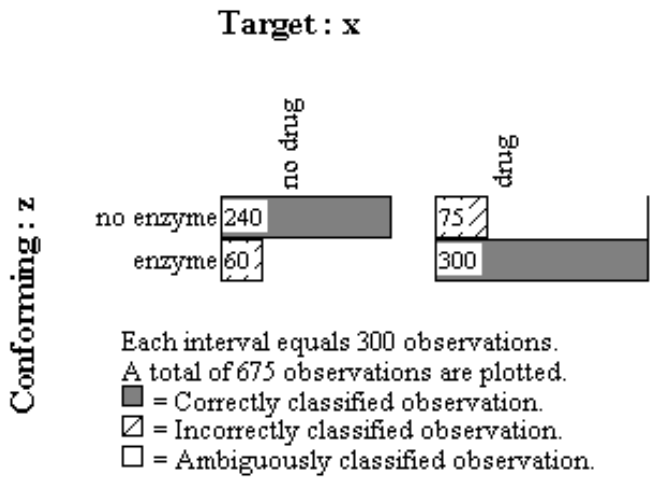
Figure 7. Multigram showing results conforming mediating cause (Z, enzyme) to initial cause (X, drug) for only those observations classified correctly in first step of the